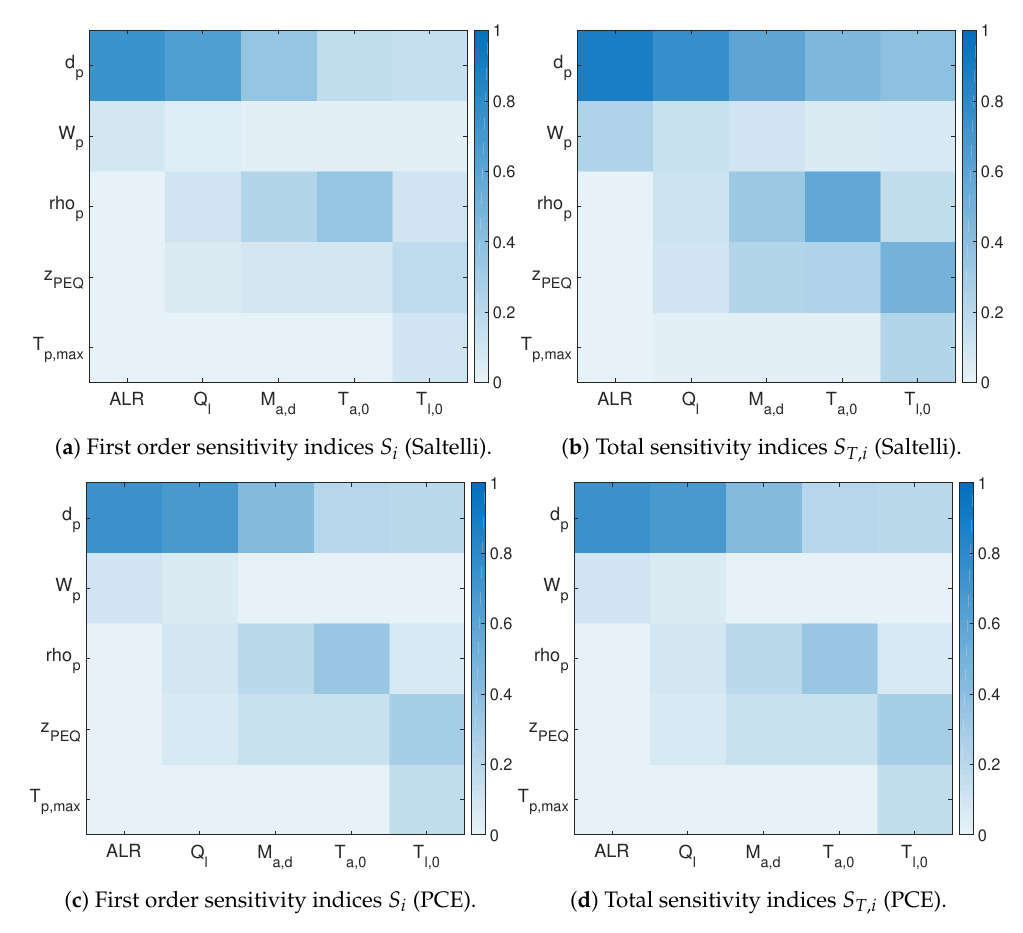
Figure 5. Qualitative comparison of sensitivity heat maps for a spray dryer with the pneumatic nozzle computed using Saltelli’s approximation with 23,000 samples and third order PCE with 200 samples. The x-axis shows the operating parameters, and the y-axis shows the output parameters